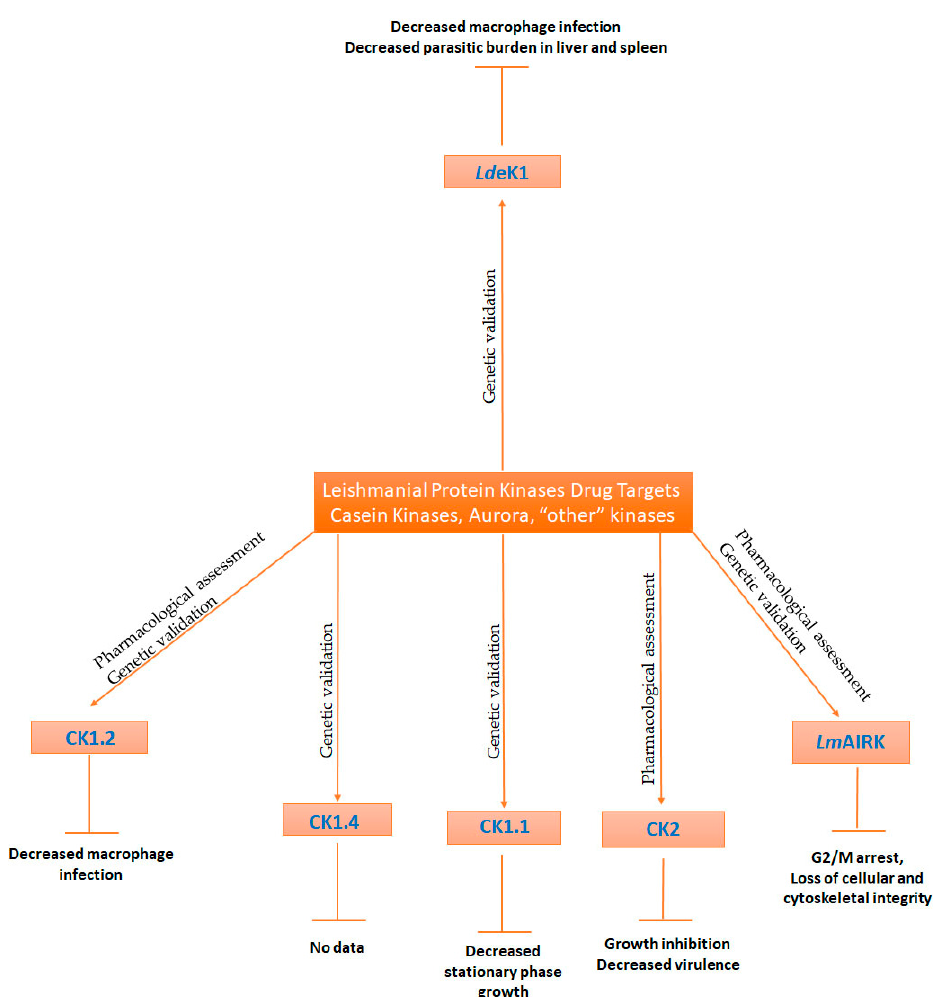
Figure 3. Leishmanial Protein kinases from the Casein kinase family, Aurora and “other” kinase families, that could serve as drug targets. The ePKs displayed have been genetically and/or pharmacologically validated. The effects on their biological role and/or on their virulence upon pharmacological and/or genetic inhibition is also displayed in the diagram.